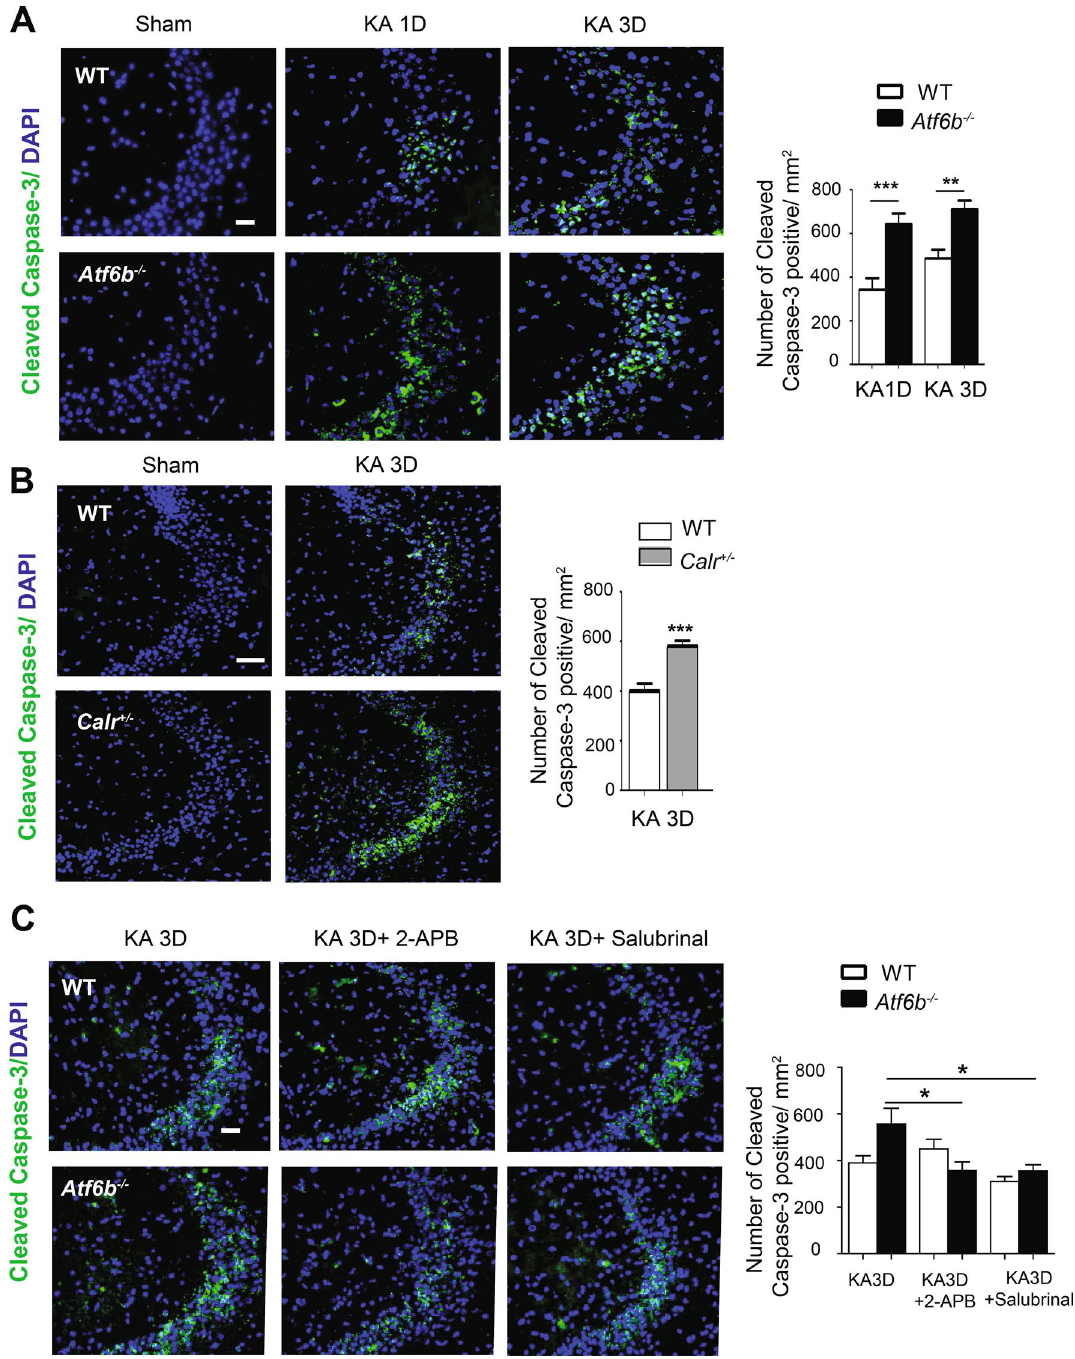
Figure 7. Neuroprotection by ATF6β and CRT through Ca 2+ regulation in KA-injected mice. ( A,B ) Brain sections including the CA3 area of the hippocampus from WT and Atf6b −/− mice ( A ) (n = 6–7 mice) or WT and Calr + /− mice ( B ) (n = 6 mice) were subjected to immunohistochemical staining for cleaved caspase-3. The right graphs depict the number of cleaved caspase-3-positive CA3 neurons. Data are shown as mean ± SEM. **p < 0.01, ***p < 0.001 by a two-way ANOVA followed by the Bonferroni test in ( A ) and by the Mann–Whitney U test in ( B ). Scale bar: 50 µm. ( C ) Brain sections including the CA3 area of the hippocampus obtained from WT and Atf6b −/− mice at 3 days after injection with KA, KA plus 2-APB and KA plus salubrinal were subjected to immunohistochemical staining for cleaved caspase-3. The right graph depicts the number of cleaved caspase- 3-positive cells. n = 6 mice. Data are shown as mean ± SEM. *p < 0.05 by a two-way ANOVA followed by the Bonferroni